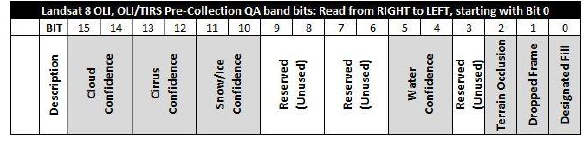
Figure 7. BQA channel coding